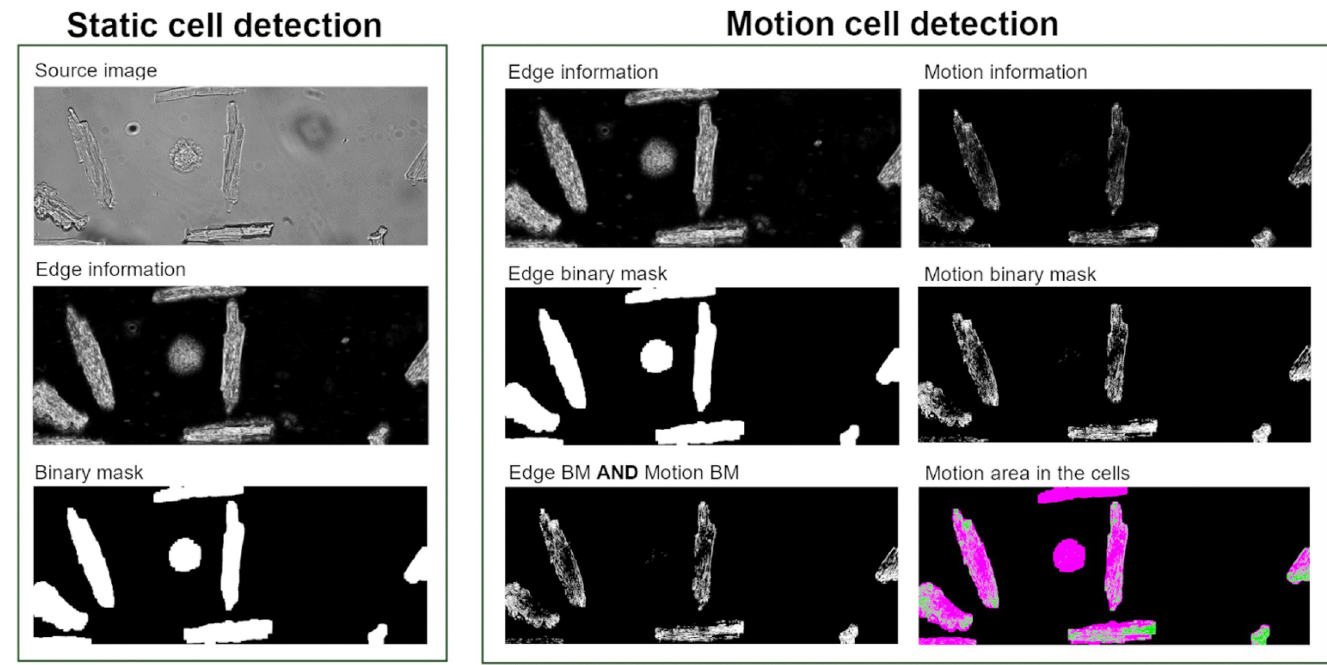
Frame layer—static cell finding. As shown in Fig 3, static cell finding detects cardiomyo- cytes based on the cell boundary irrespective of motion (S1 File). In a brightfield microscopy